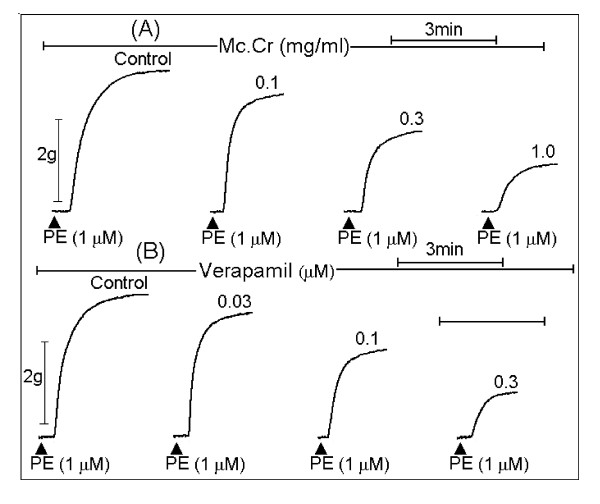
Typical tracing showing the increasing concentration-dependent suppression of (A) Mc.Cr and (B) verapamil on control phenylephrine (PE 1 μM) peaks in the normal- Ca++ and Ca++-free Kerb's solution.